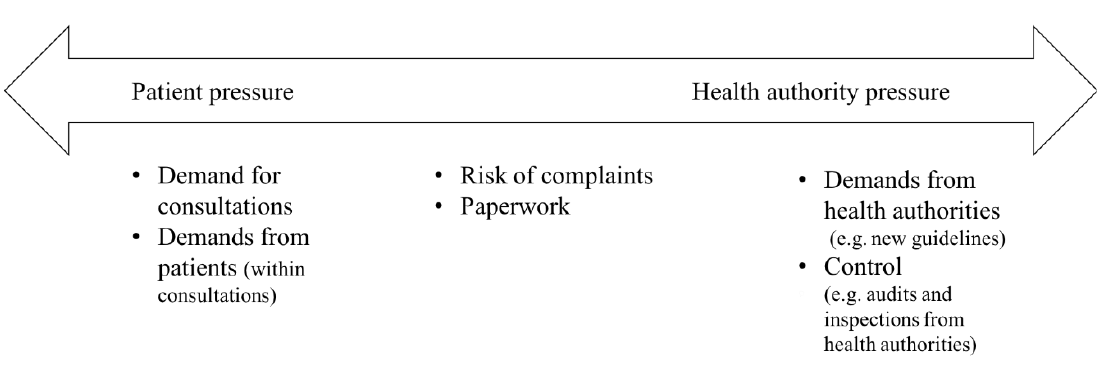
Figure 1: Measures of GP work pressure related to patients and health